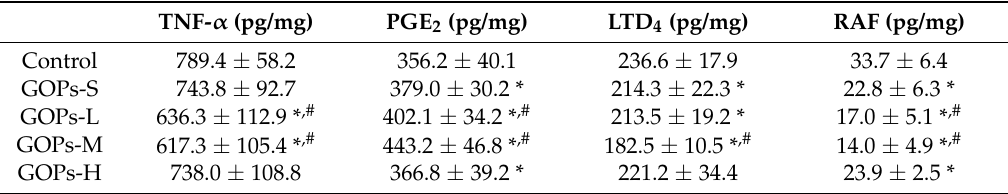
Table 2. Effect of GOPs on inflammatory parameters in paw